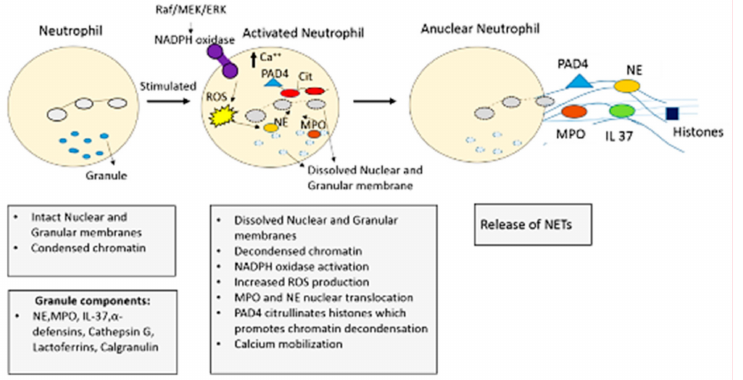
Figure 2. Basic Steps of NETs formation. Micro-organisms, PMA, LPS, endogenous DAMPs and auto-antibodies stimulate the neutrophils to release NETs through several signaling cascades and effector proteins. Activation of the NADPH oxidase via PKC and Raf/MEK/ERK signaling drives the generation of ROS and activation of Peptidyl arginine deaminase (PAD4), which citrullinates arginine on histones leading to chromatin decondensation. Then, NE and MPO are released from azurophilic granules and translocate to the nucleus to promote further chromatin decondensation. Nuclear Envelope breaks down releasing chromatin in cytosol and mixes with cytosolic proteins. Finally, NETs are